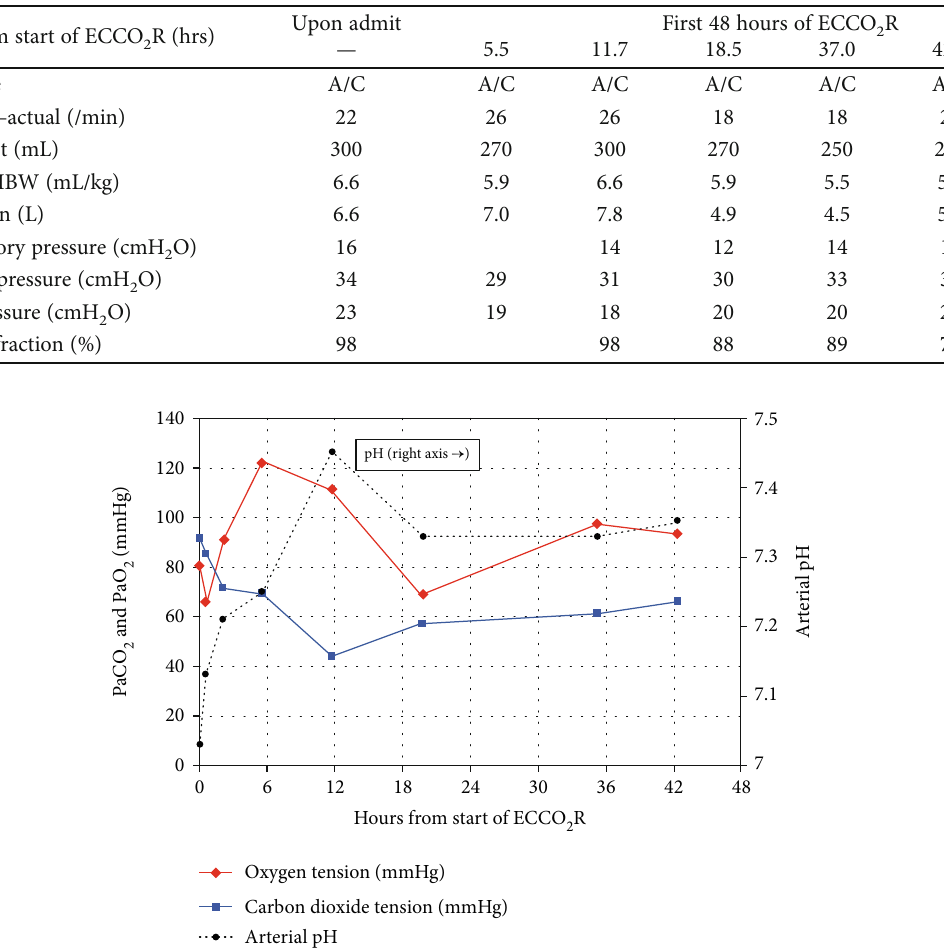
Figure 1: Arterial blood gases during the fi rst 48 hours of Hemolung